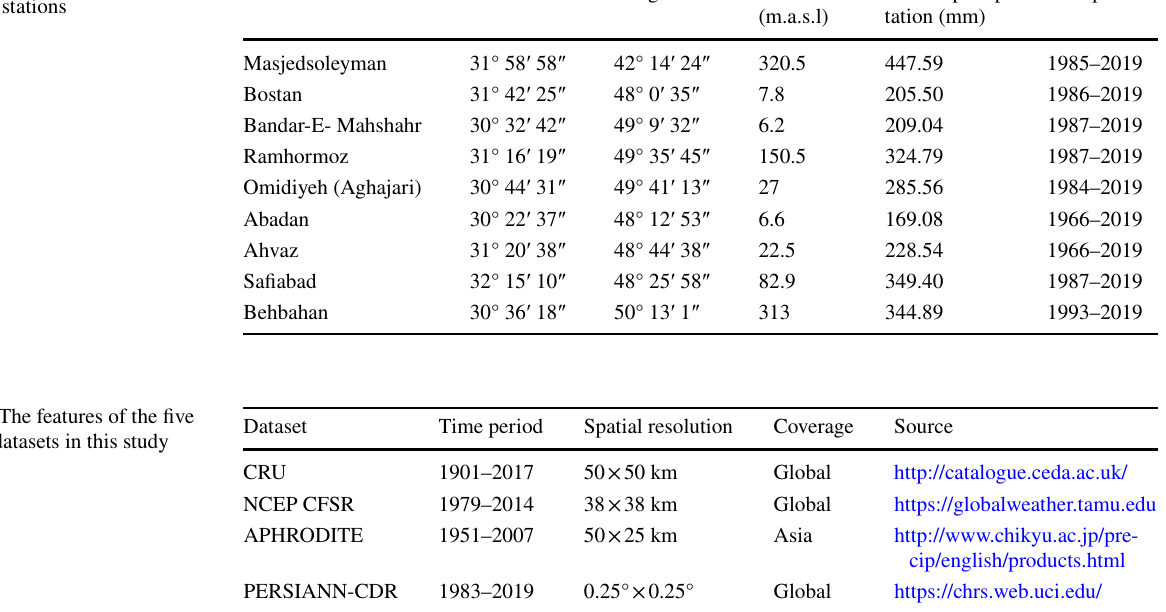
Table 1 The characteristics of synoptic stations